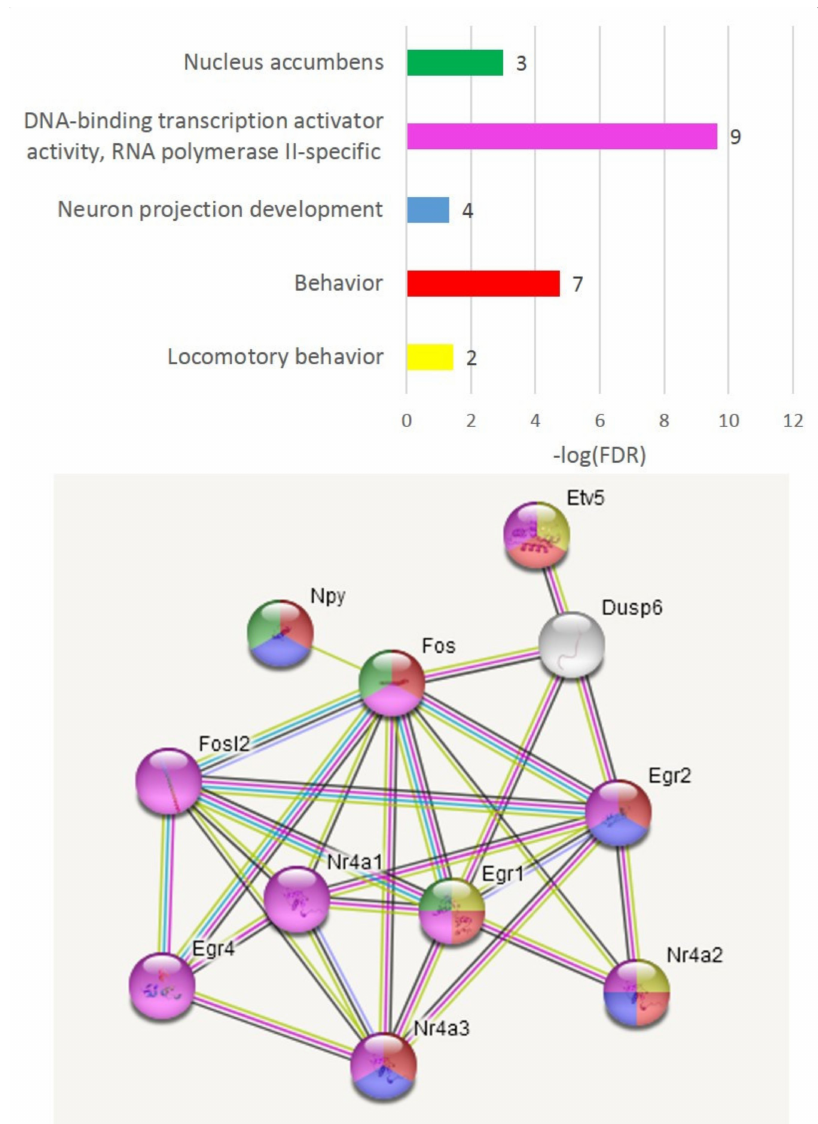
Figure 4. Eleven connected co-varied genes spanning 5 DEGs ( Egr1 , Etv5 , Fosl2 , Nr4a1 , Nr4a2 ) presented in Figure 3A. GO color coding corresponds to the plot above (gene numbers attached to bars). The DEGs in this set feature control group and are decreased in AD and A20 groups (Figure